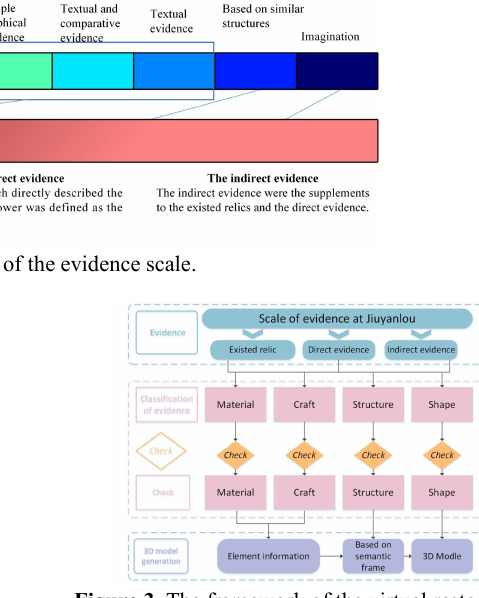
Figure 3. The framework of the virtual restoration for the Nine-eyes